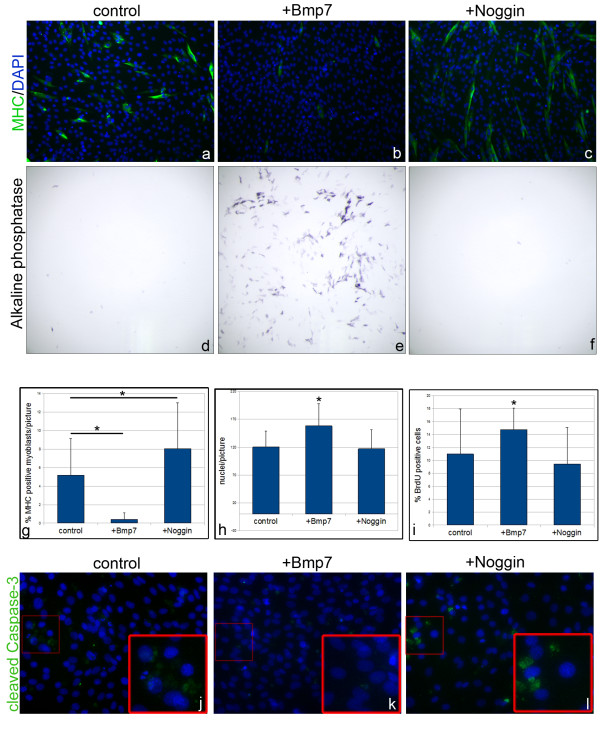
Bmp7 and Noggin regulate terminal differentiation of C2C12 cells in opposite ways. C2C12 cells were treated in control medium (A,D,J) or supplemented with Bmp7 (B,E,K) or Noggin (C,F,L) and analyzed for terminal myogenic differentiation (MHC expression) (A-C), osteoblast differentiation (alkaline phosphatase activity) (D-F), BrdU incorporation (I) and apoptosis (J-L). (A-C) terminally differentiated, MHC expressing myoblasts/myotubes can be detected in control cultures (A). Bmp7 treatment inhibits myogenic differentiation (B), whereas Noggin treatment leads to enhanced myotube formation (C). DAPI was used to counterstain nuclei (100× magnification). (D-F) C2C12 cells express alkaline phosphatase upon Bmp7 treatment (E) but not in untreated (D) or Noggin-treated cultures (F) (50× magnification). (G) Statistical analysis using the generalized Wilcoxon test demonstrates significantly reduced numbers of MHC-positive cells after Bmp7 treatment and increased numbers after Noggin treatment (n = 6, 2 individual experiments in triplicates; *p < 0.005). Cell number (H) and BrdU incorporation (I) are upregulated after Bmp7 treatment (n = 6, 2 individual experiments in triplicates *p < 0.005; Wilcoxon test). (J-L) the apoptotic marker cleaved Caspase3 is absent after Bmp7 treatment (K) while apoptosis can be detected in control (J) and Noggin-treated cultures (L) (200× magnification).